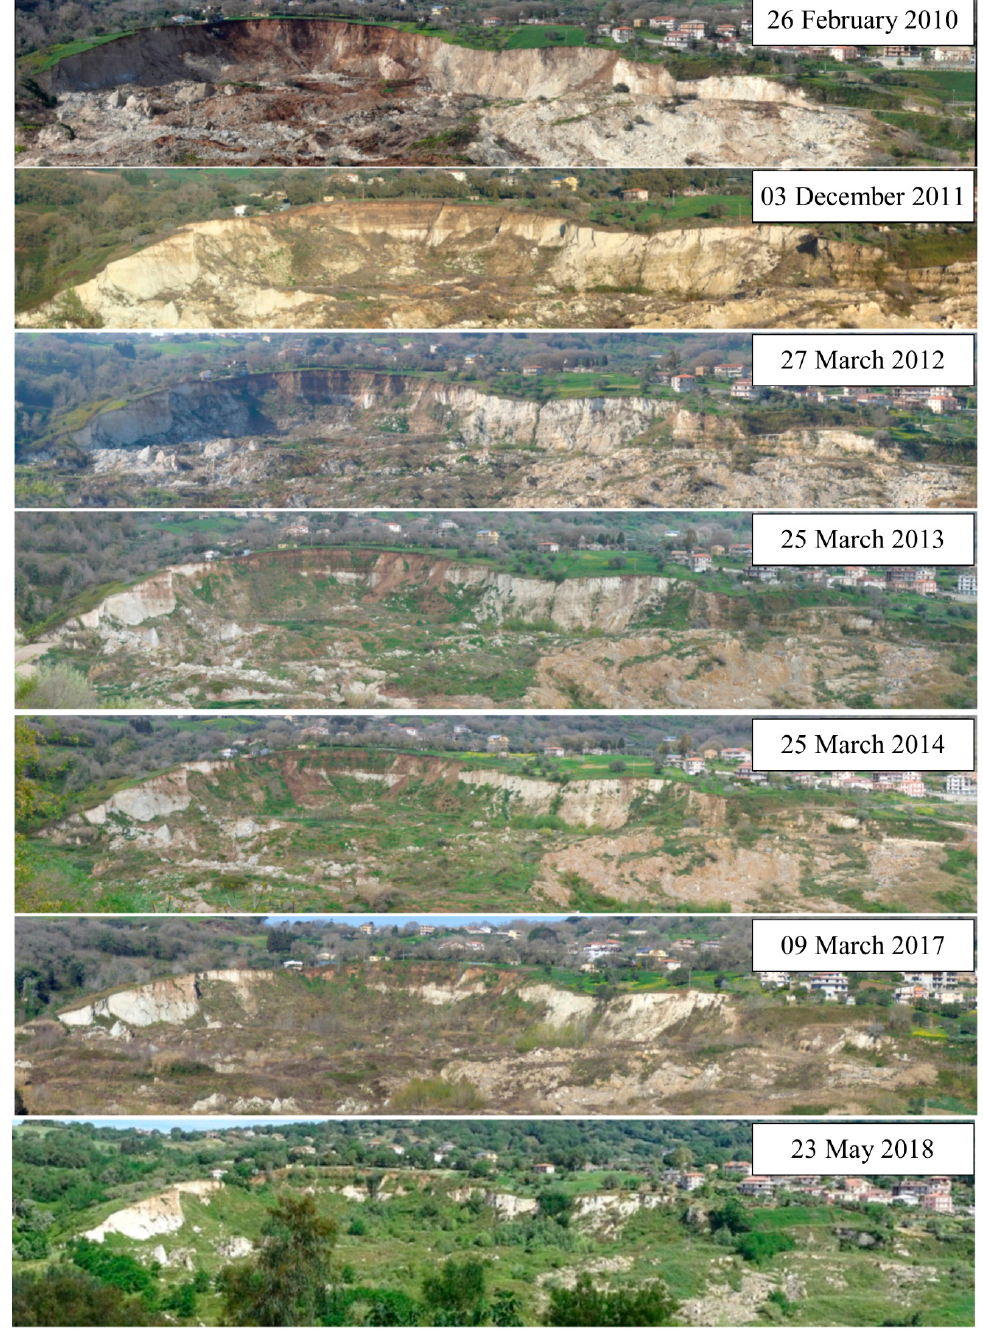
Figure 5. Panoramic images time series showing the evolution of the Maierato landslide scarp in the last years.